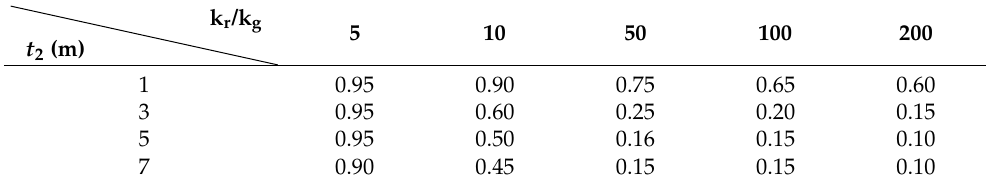
Table 4. Recommended value of water pressure reduction coefficient of class A surrounding rock.